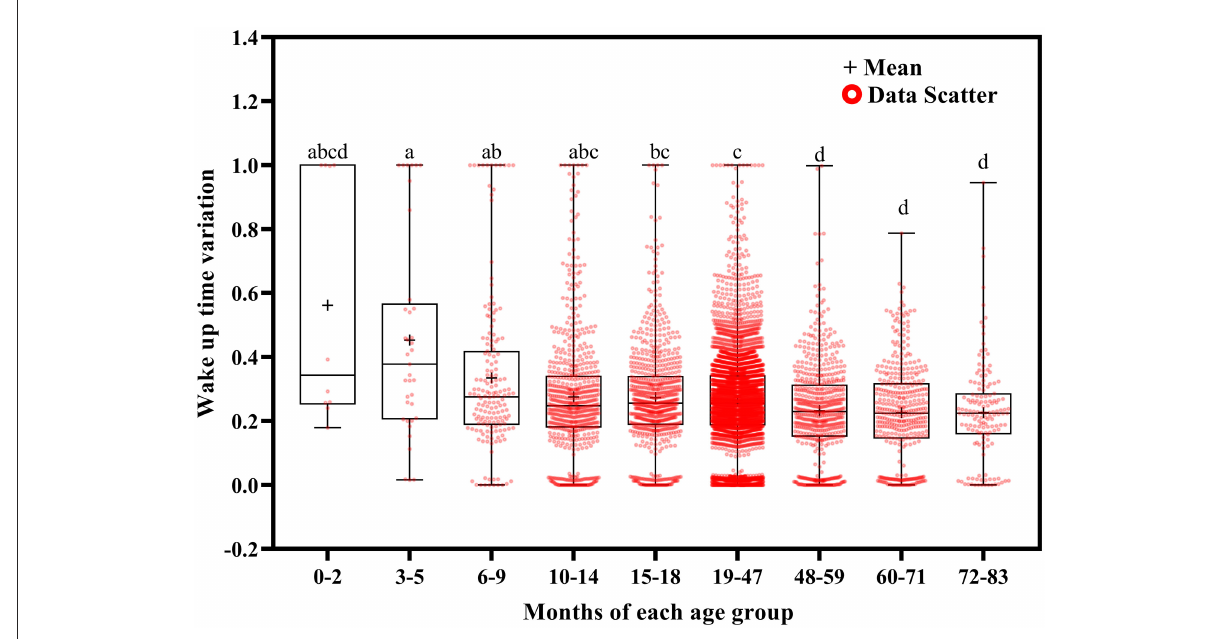
FIGURE4 Results of the one-way ANOVA for wake up time variation stratified by age.